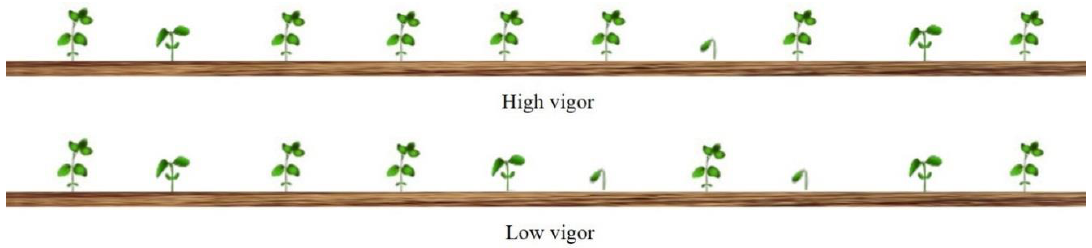
Figure 4. Schematic representation of vigor e ff ect on soybean seed emergence. Plant from seeds with a high level of vigor presented higher uniformity and earlier emerging plants than plants with low seed vigor level.